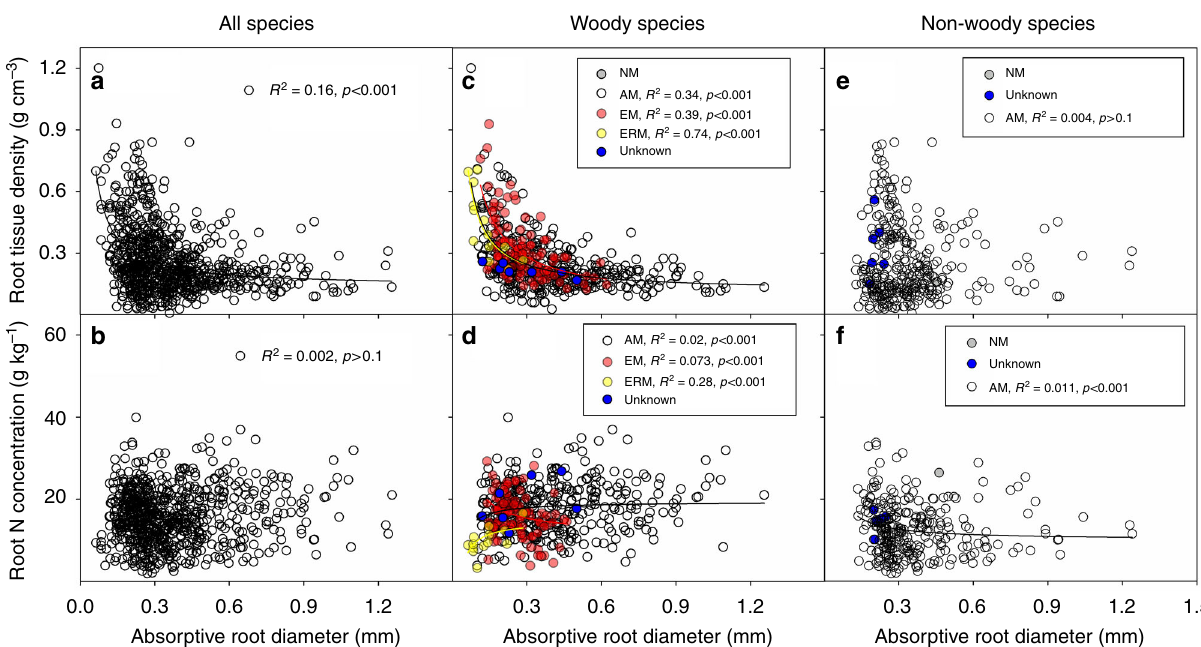
Fig. 2 Nonlinear root trait relationships. Allometric root structure-derived nonlinear relationships between absorptive root diameter and root tissue density and root N concentration for different mycorrhizal types of all species ( a , b ), woody ( c , d ) and non-woody species ( e , f ). NM = non-mycorrhiza; AM = arbuscular mycorrhiza; EM = ectomycorrhiza; ERM = ericoid mycorrhiza; Unknown = unknown mycorrhizal status. The data sources are presented in Supplementary Data 1. For woody and non-woody species, the statistical signi fi cance for the regressions is only shown for the three main mycorrhizal types. The insets show the fi tness of the allometry-based nonlinear regressions